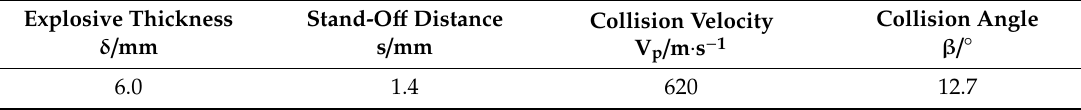
Figure 3. Weldability window of AA5051/AZ31B and collision velocities from setting groups. Table 1. Initial parameters used for explosive